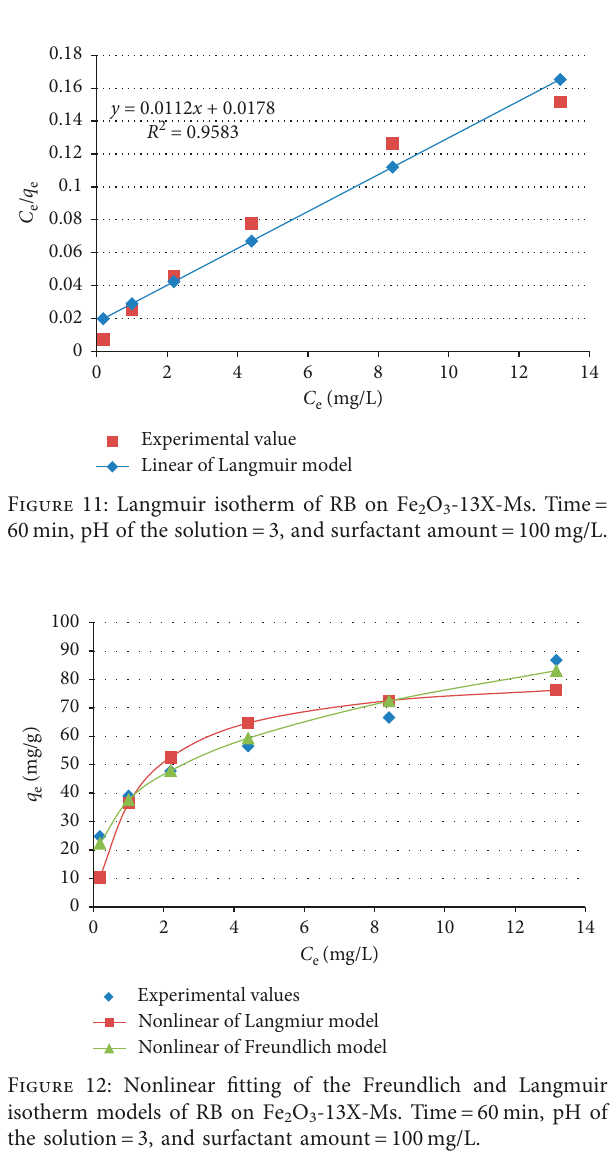
60 min, pH of (cid:30) 100 (cid:30)